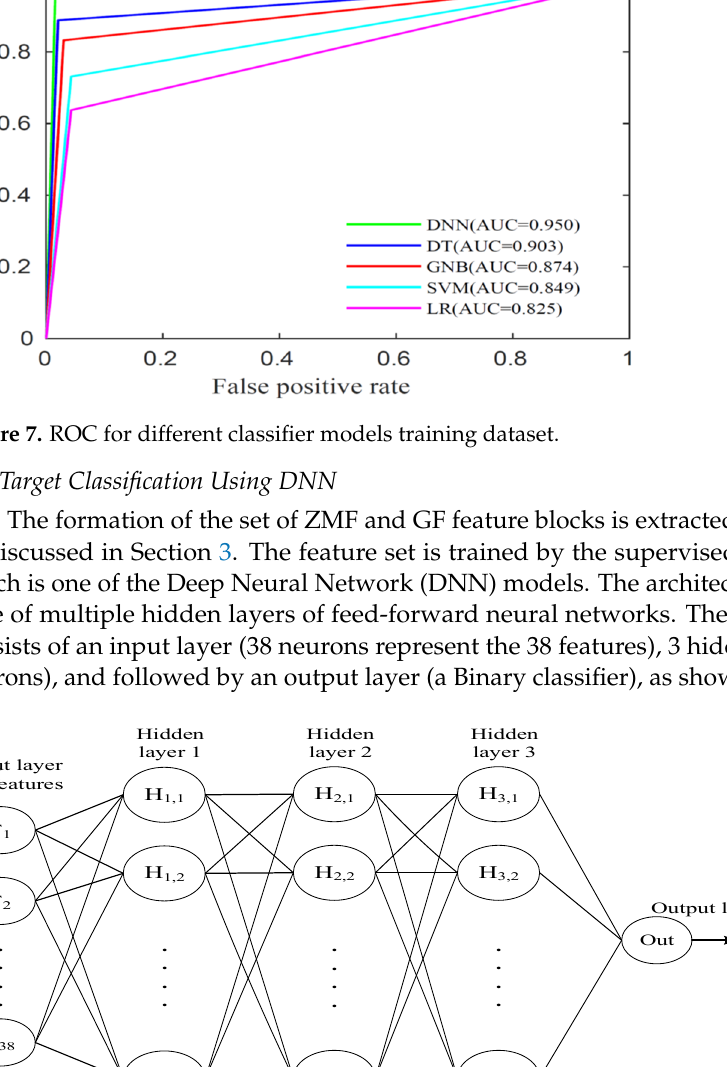
Table 3. Test evaluation metrics of a dataset for different classifiers with image block size 32 × 32.